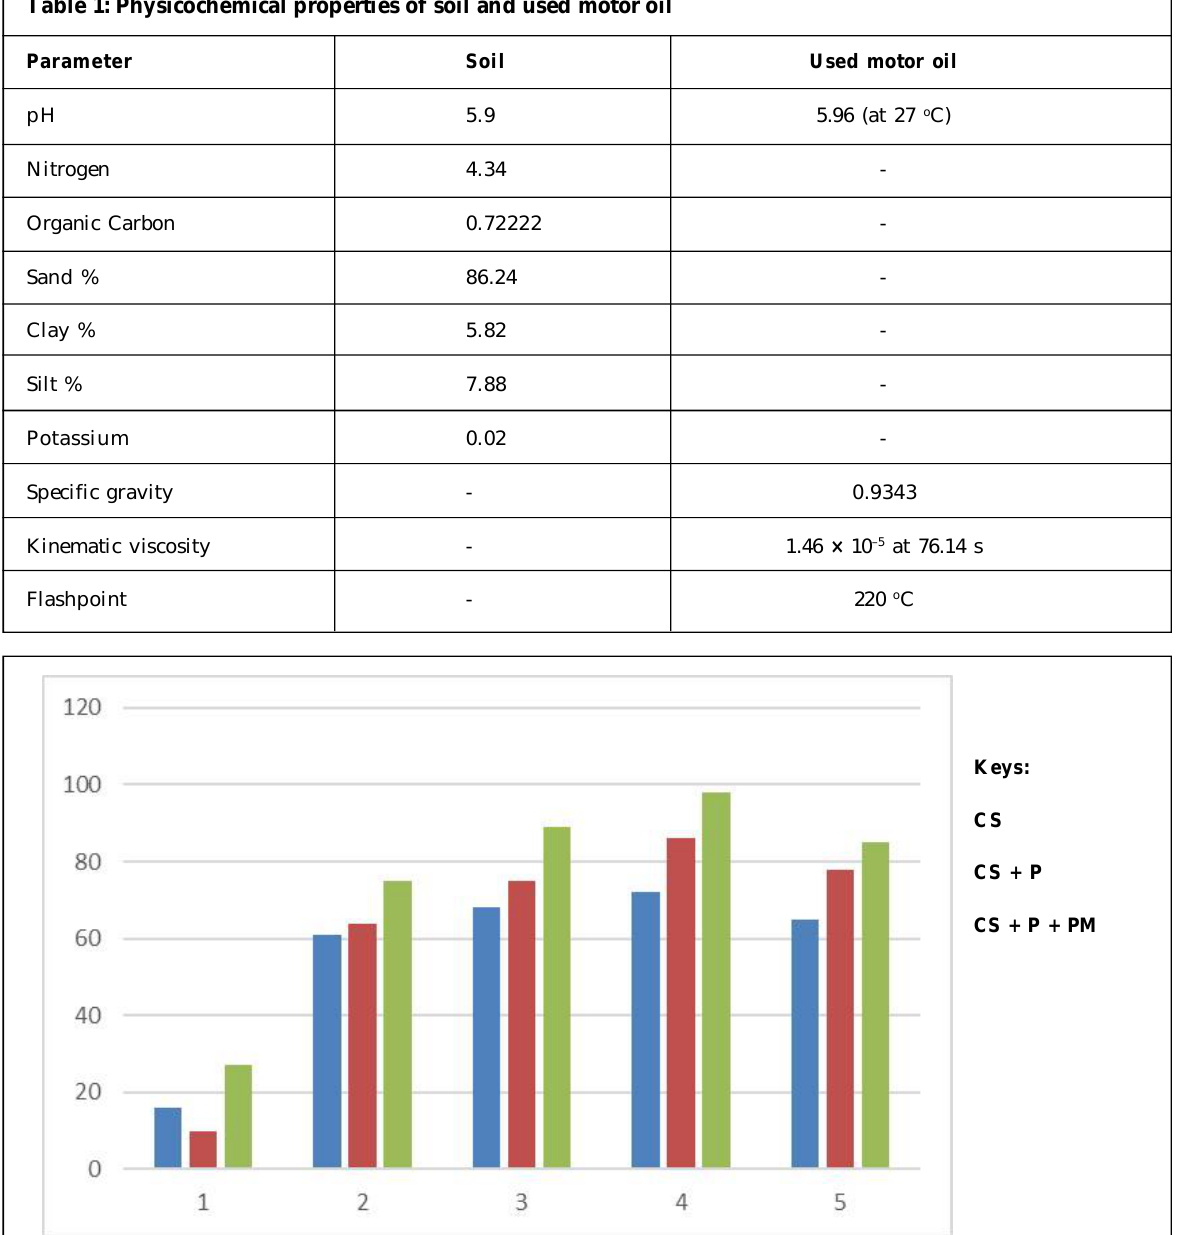
Table 1: Physicochemical properties of soil and used motor oil Parameter